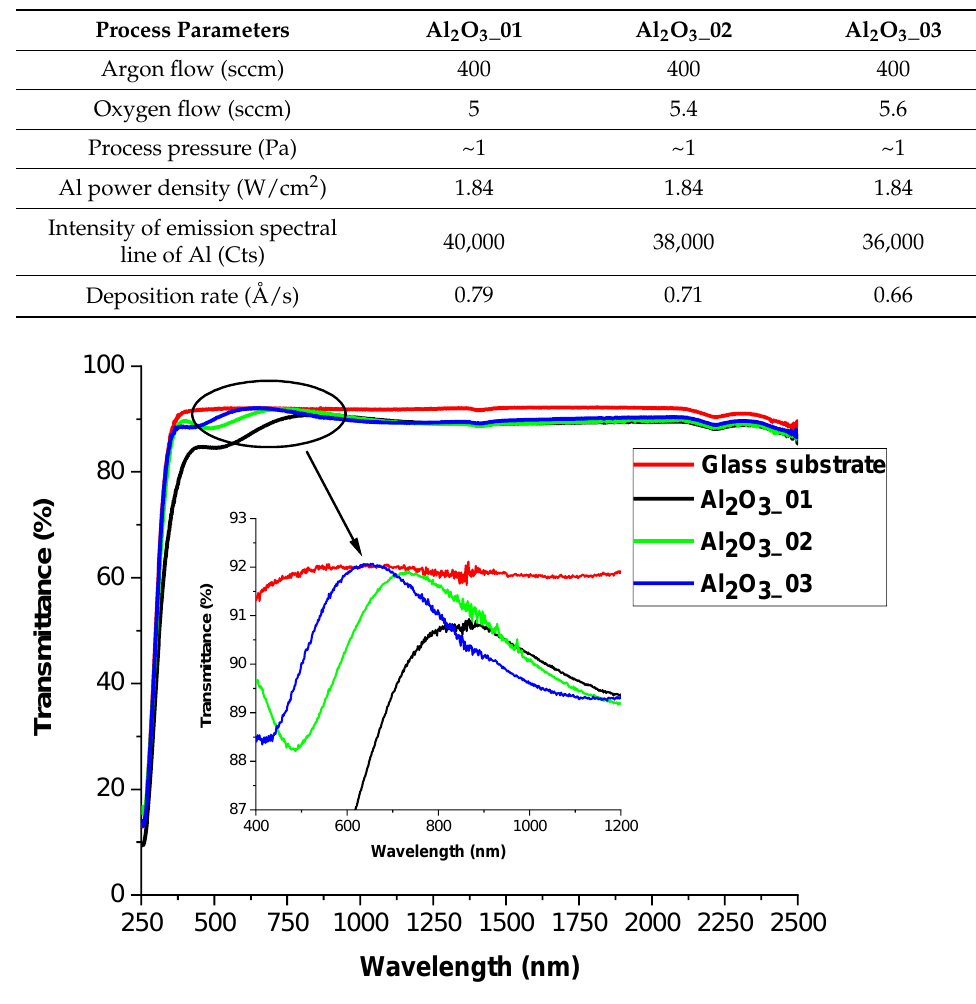
Figure 4. Comparison between the transmittance curves of glass substrate and Al 2 O 3 samples deposited by varying the intensity of the emission spectral line of